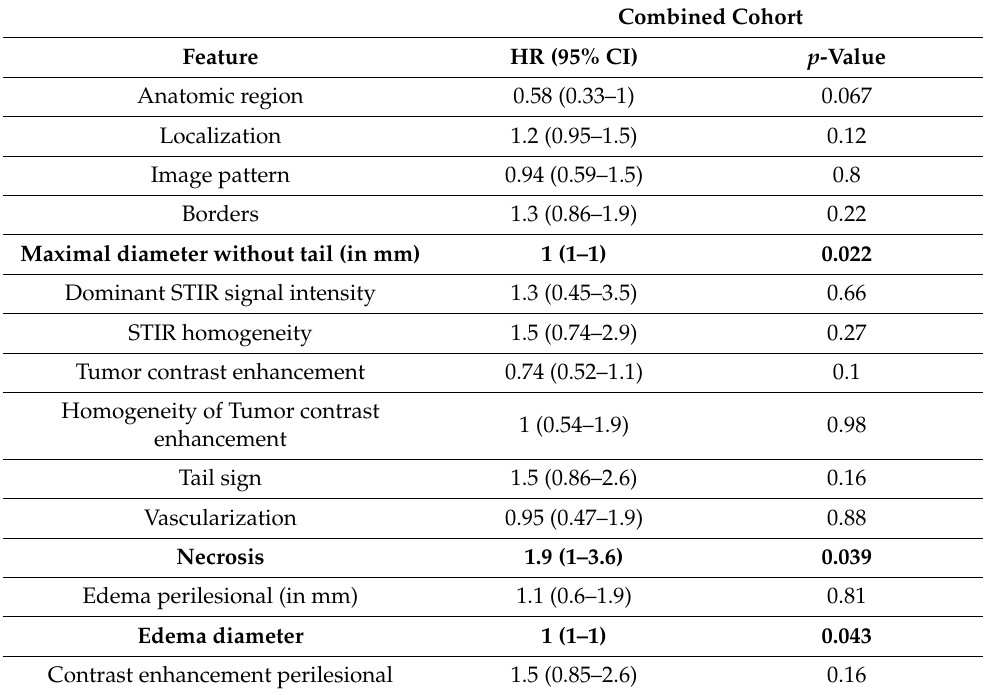
Table 3. Cox proportional hazards regression of semantic features for patients’ overall survival.